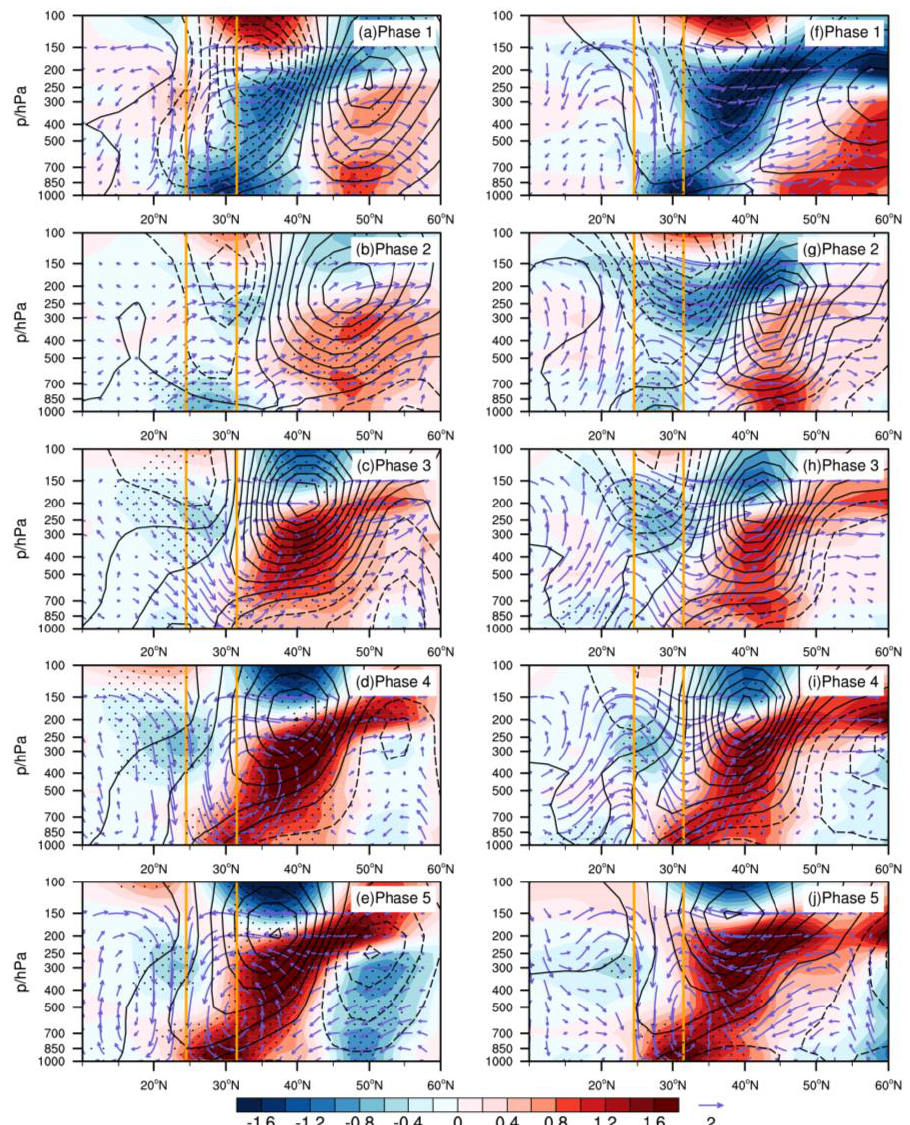
Figure 9. The vertical-meridional cross section of 10–30 d filtered temperature (shading; units: °C), geopotential height (contour; units: gpm) and wind (vector; meridional wind units: m/s, vertical velocity units: − 10 − 2 Pa/s) averaged along the longitudes 108° – 122° E during the ( a – e ) first and ( f – j ) second type of PHTEs. Yellow lines indicate the latitude of the Jiangnan region. Black dots represent temperature anomalies exceeding the 90% confidence level, respectively.